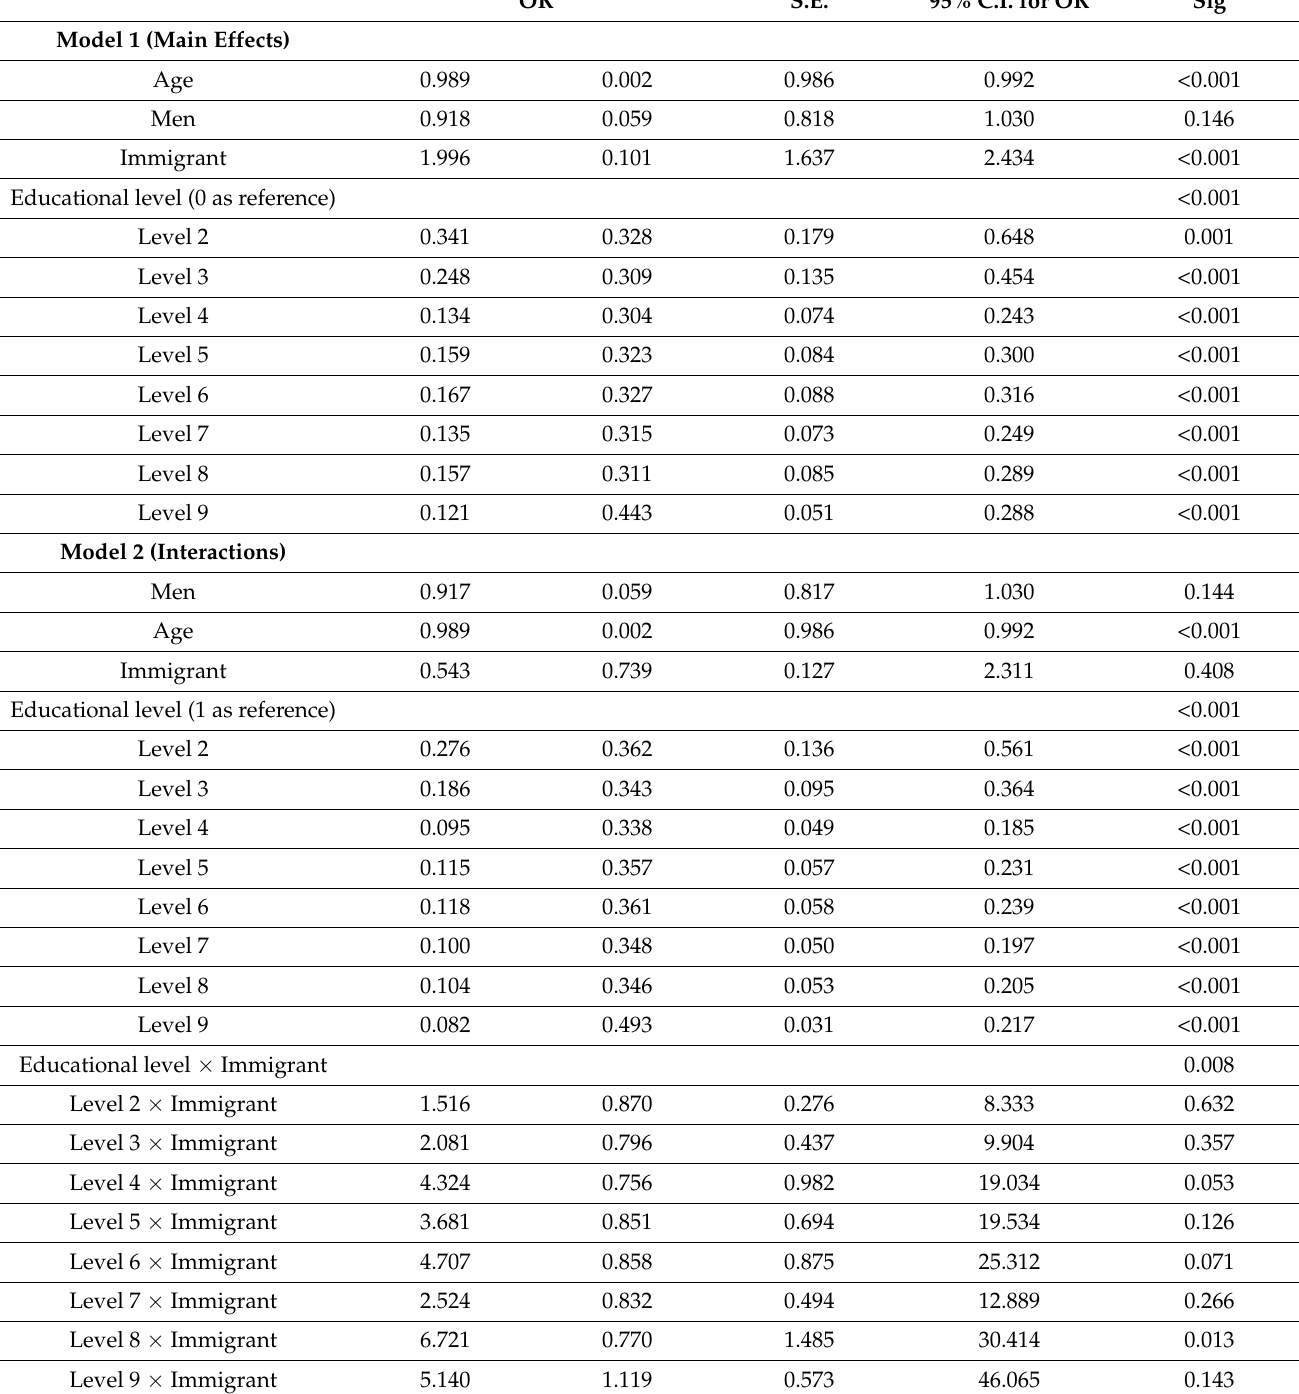
Table 2. Pooled sample logistic regression